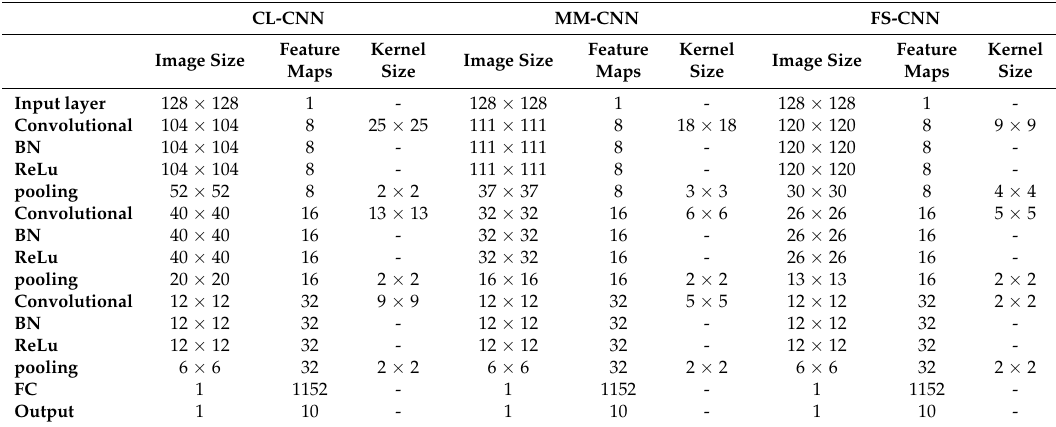
Table 1. The architecture of the three CNN